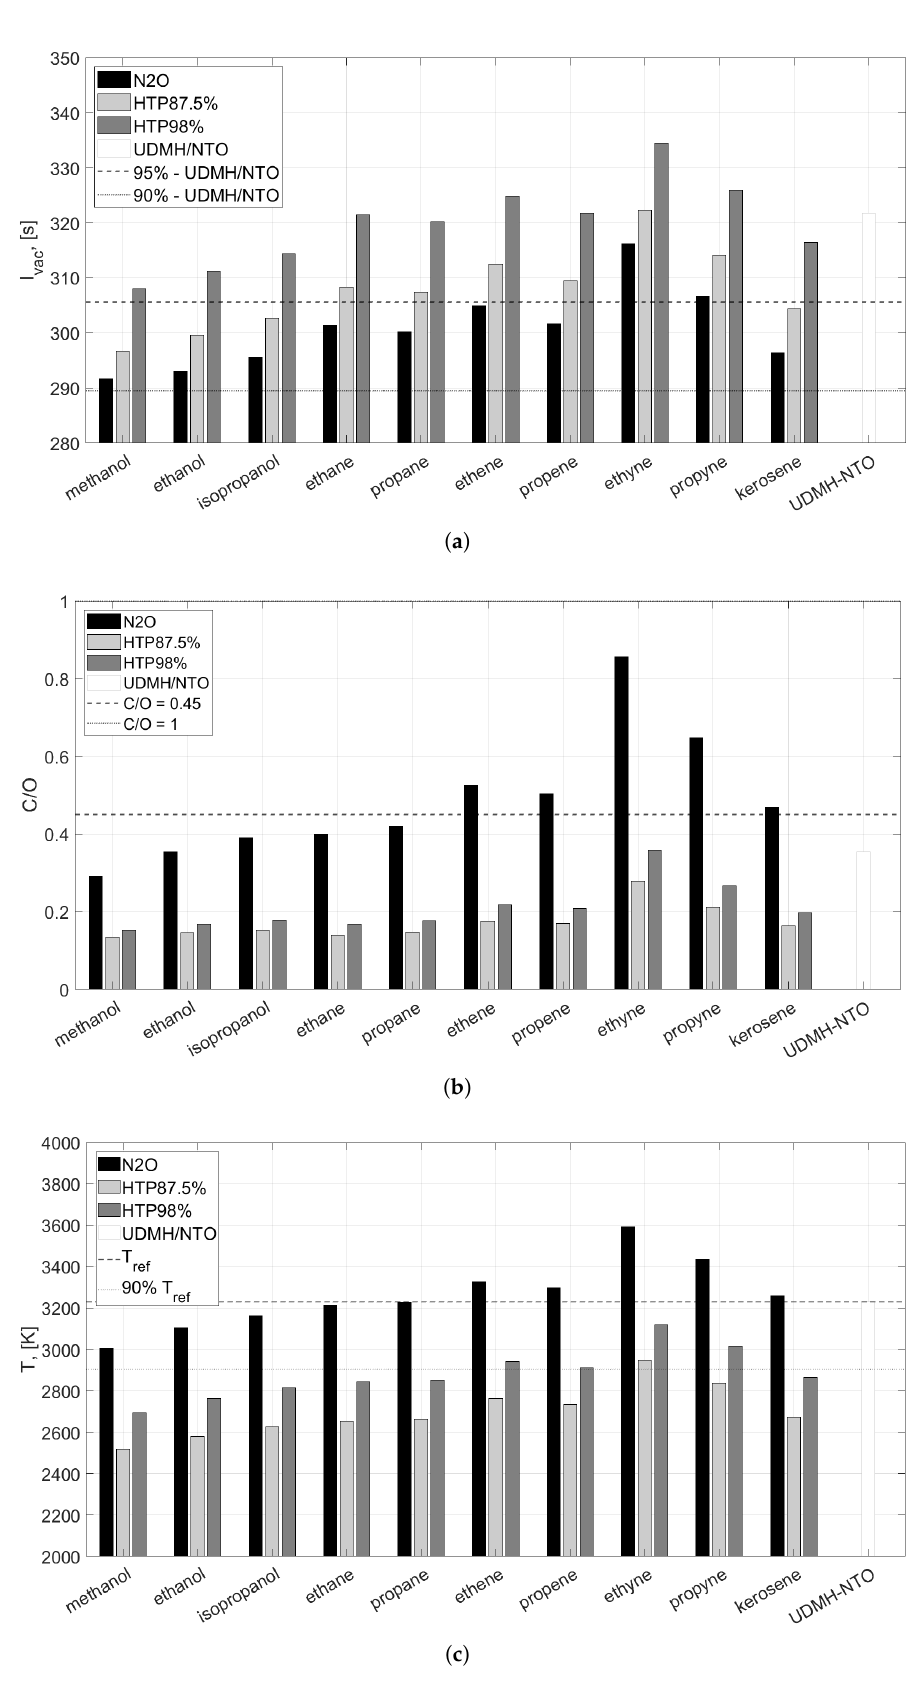
Figure 6. Performance comparison between selected green propellant couples: ( a ) vacuum specific impulse; ( b ) sooting behavior; and ( c ) chamber